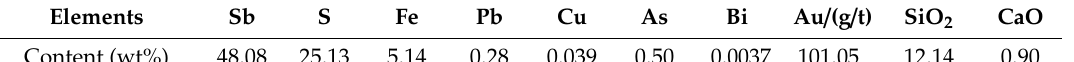
Table 1. Chemical composition of central south stibnite concentrate.